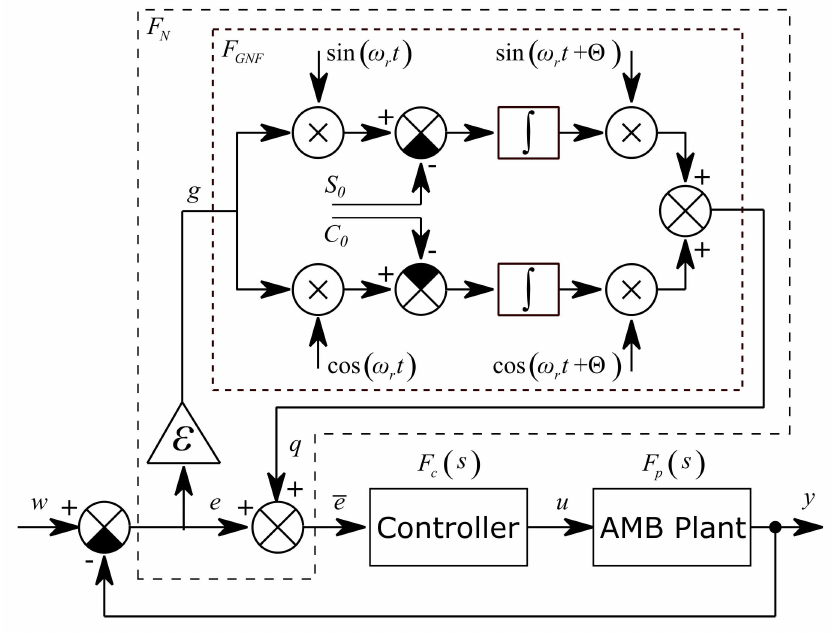
Figure 5. AMB closed loop control with the general notch filter as a vibration